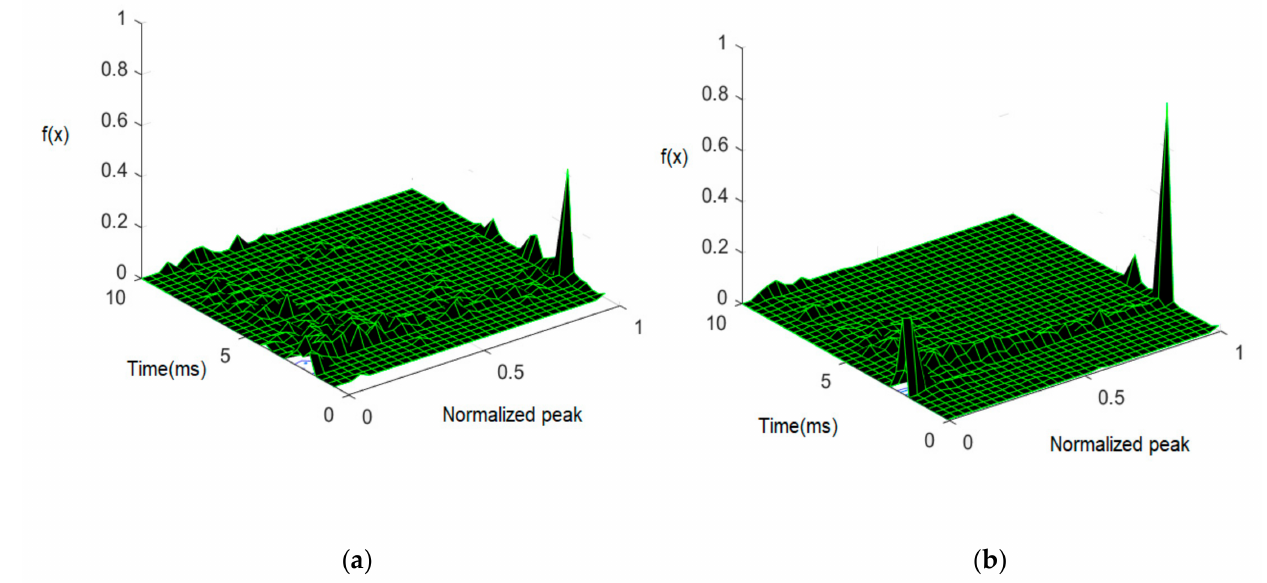
Figure 7. Probability 3D plot for normalized peak values and time intervals of IE signals for slab 6 ( a ) defect ( b ) sound. Table 3. Statistical results based on time interval preprocessed IE signals collected from defect and sound part. (a)